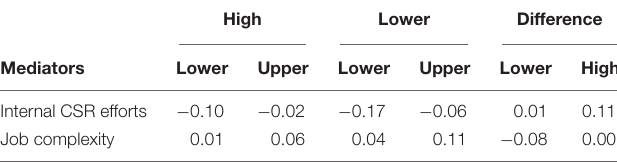
TABLE 2 | Supplemental moderated mediation